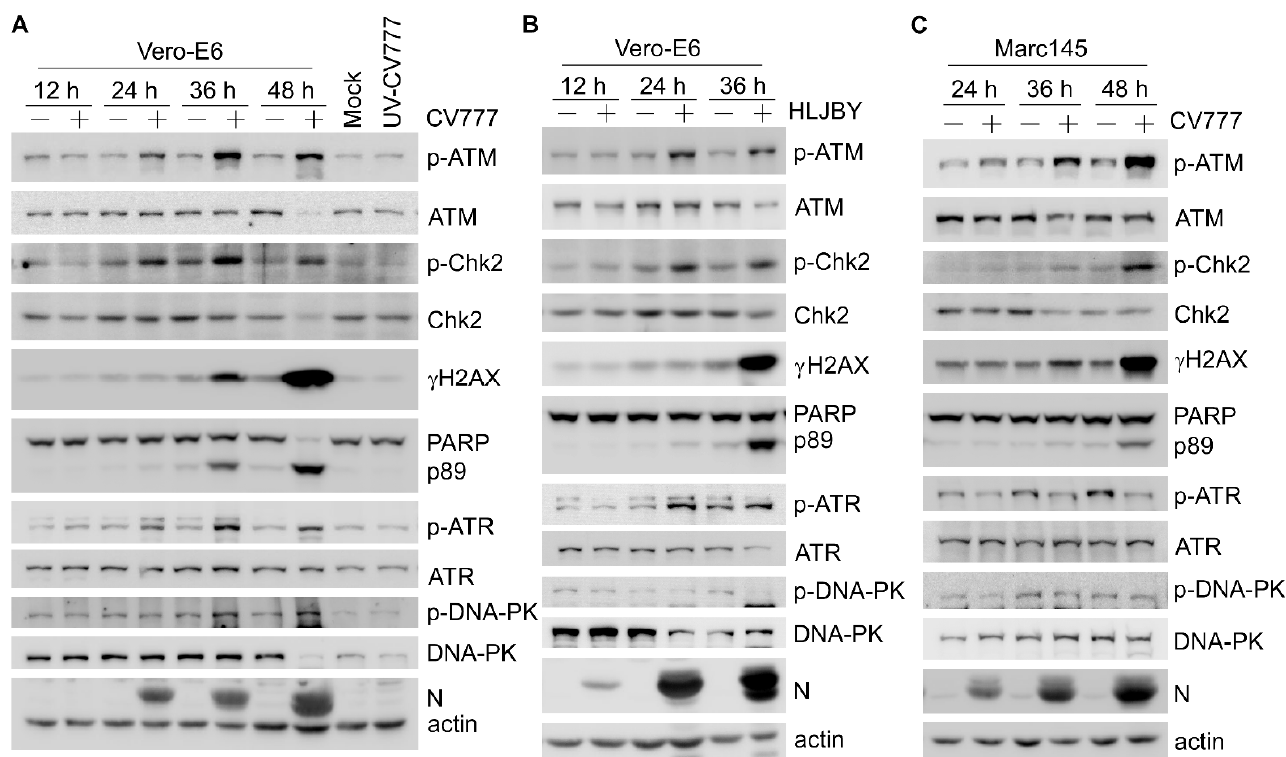
Figure 1. PEDV infection activates ATM ‐ dependent DNA damage response. ( A ) Western blots